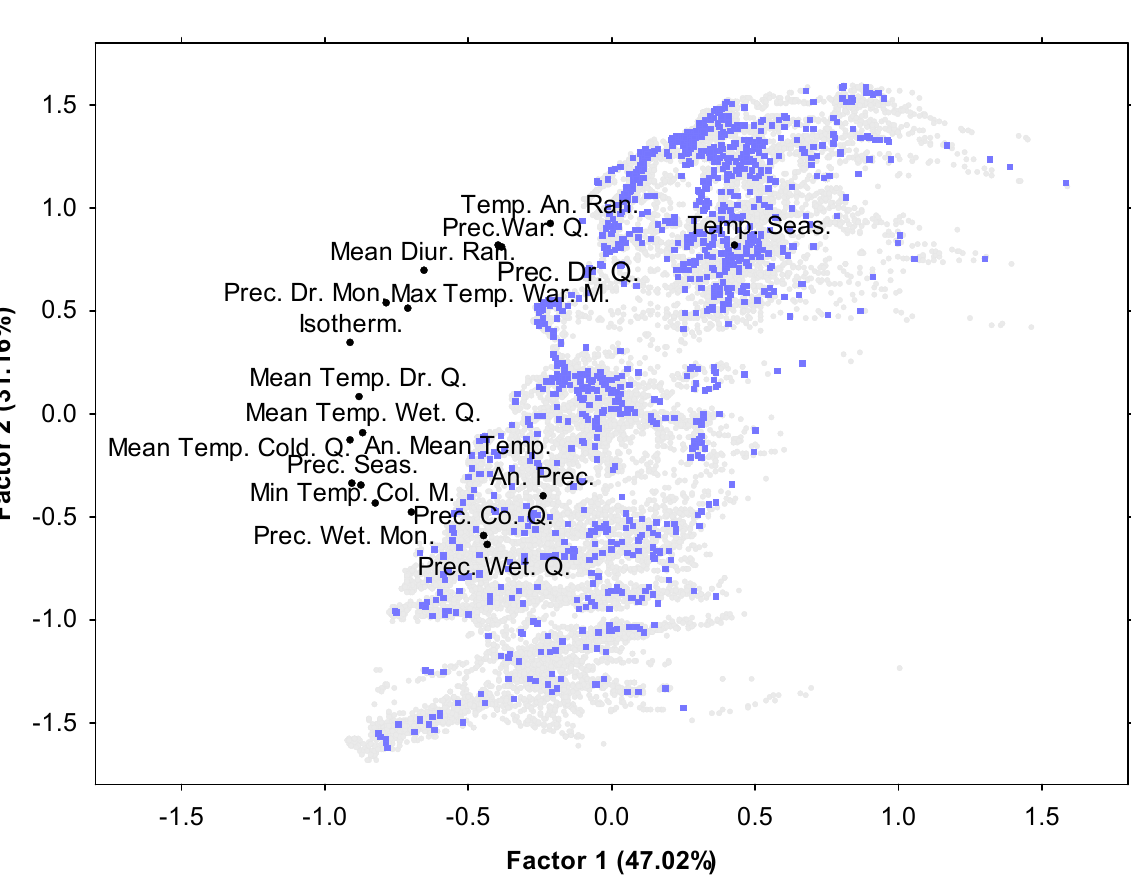
Figure 3. The two first axes of the principal components analysis (PCA) of bioclimatic variables shaping the climate profile in the studied area for the invasion of Solanum elaeagnifolium in Greece. Factor 1 and Factor 2 explain 47.02% and 31.16% of variance, respectively. Blue factor scores: invaded areas by S. elaeagnifolium ; grey factor scores: non-invaded areas by S. elaeagnifolium . Factor coordinates: Temp. An. Ran.—Temperature Annual Range; Temp. Seas.—Temperature Seasonality; Prec. War. Q.—Precipitation of Warmest Quarter; Prec. Dr. Q.—Precipitation of Driest Quarter; Mean Diur. Ran.—Mean Diurnal Range; Prec. Dr. Mon.—Precipitation of Driest Month; Max Temp. War. M.—Max Temperature of Warmest Month; Isotherm.—Isothermality; Mean Temp. Dr. Q.—Mean Temperature of Driest Quarter; Mean Temp. Wet. Q.—Mean Temperature of Wettest Quarter; Mean Temp. Cold. Q.—Mean Temperature of Coldest Quarter; An. Mean Temp.—Annual Mean Temperature; Prec. Seas.—Precipitation Seasonality; An. Prec.—Annual Precipitation; Min Temp. Col. M., Min Temperature of Coldest Month; Prec. Co. Q.—Precipitation of Coldest Quarter; Prec. Wet. Mon.—Precipitation of Wettest Month; Prec. Wet. Q.—Precipitation of Wettest Quarter. For analytical presentation of bioclimatic data in the area studied, see Appendix S3, Table S2.